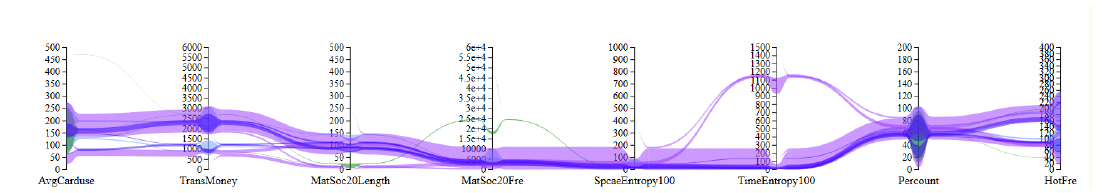
Figure 4. Parallel coordinate graph representing behavior features of a